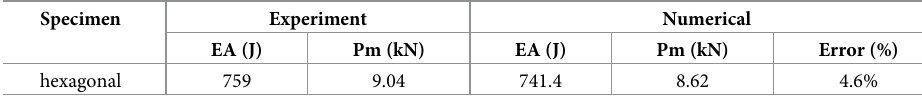
Table 2. Comparison between the FE simulation and experimental results [26].